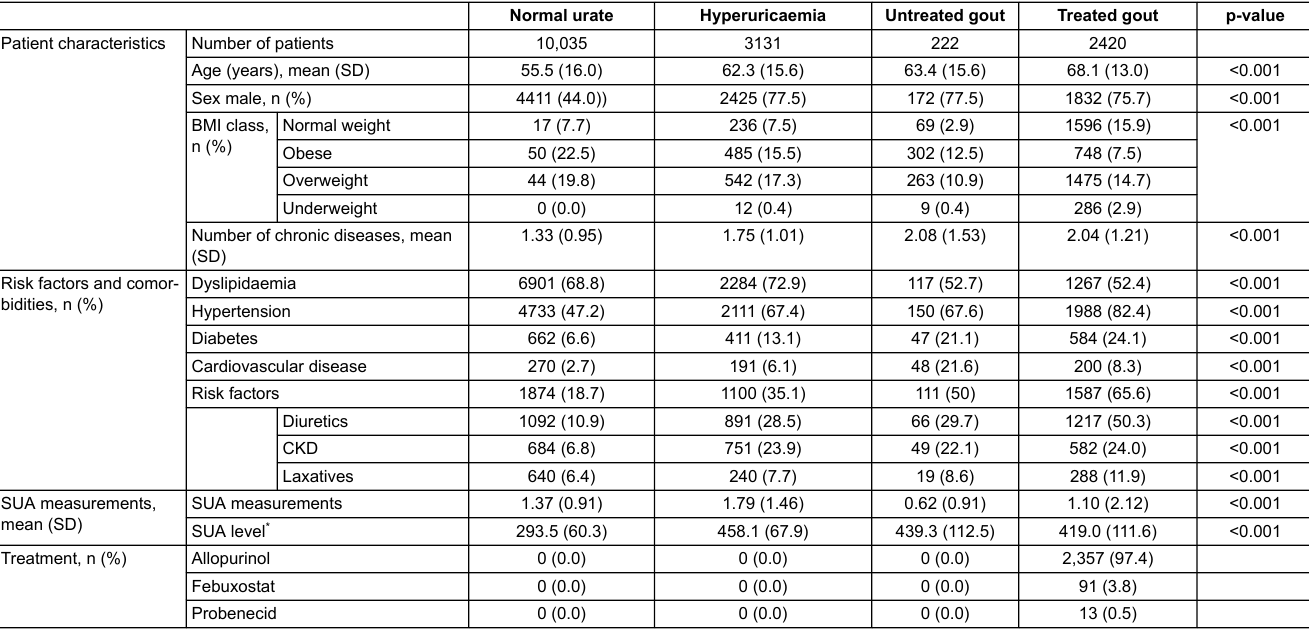
Table 1: Patient characteristics according to defined subgroups.